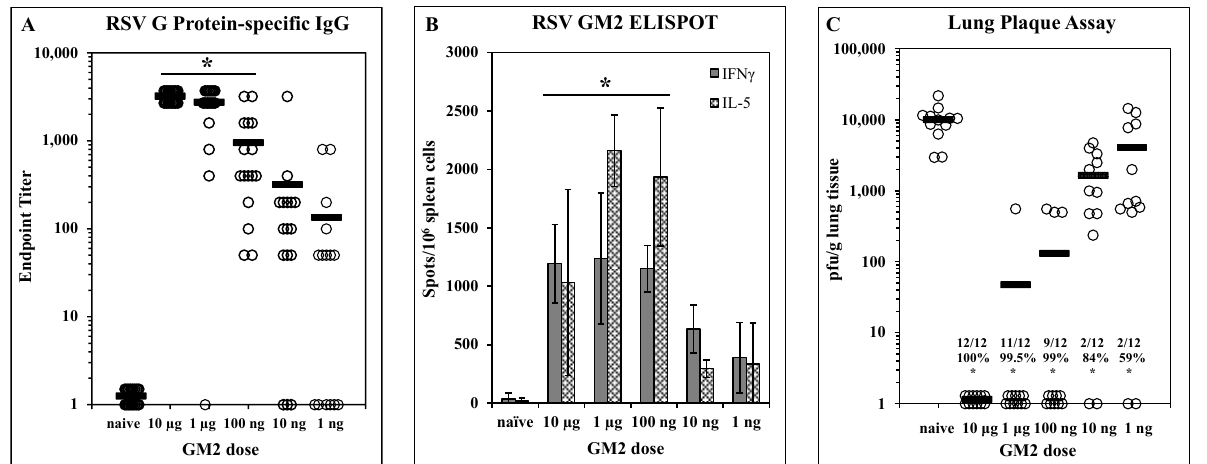
Figure 2. Dose-dependent immunogenicity and efficacy of LbL-MP loaded with RSV GM2 epitopes. BALB/c mice were immunized on days 0 and 21 with the indicated doses of GM2 LbL-MP, challenged with RSV on day 35, and sacrificed for plaque assay on day 40. ( A ) Day 28 post-boost serum antibody titers measured by RSV G protein ELISA. Endpoint titers of individual mice (open circles) and group means (bars). * p < 0.05 compared to naïve. ( B ) Day 28 spleen cell ELISPOTs restimulated in vitro with a pool of M2 81-95 and G 169-198 peptides. Mean ± SEM spots/10 6 cells of 3 mice/group. * p < 0.05 compared to naïve for both analytes by t-test. ( C ) Lung viral titers 5 days post-challenge. Number of plaques per gram of lung tissue for individual mice (circles) and group means (bars). Insets show number of mice with no detectable plaques ( n = 12 mice per group), average % reduction in plaques per group, and * p < 0.05 compared to the naïve group.